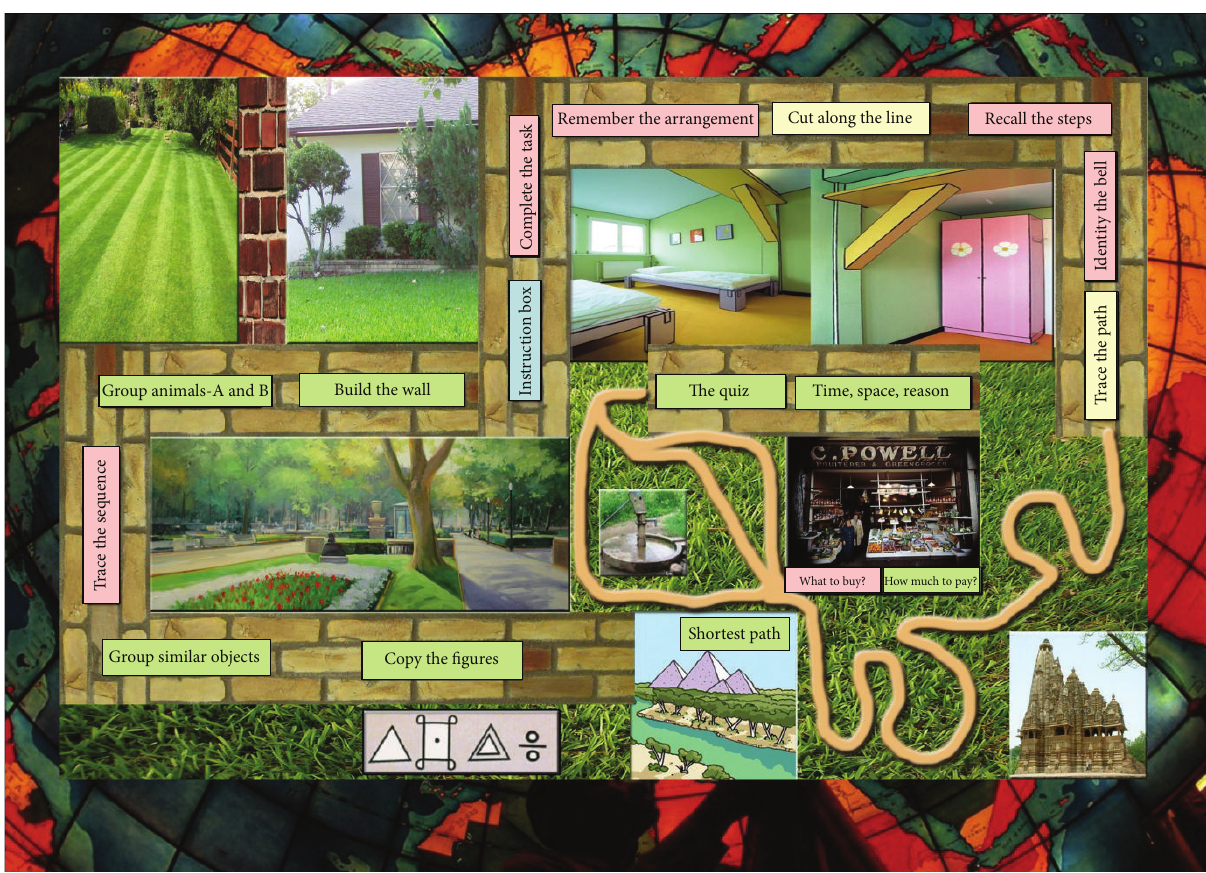
Figure 1: MALT test board. The test is administered clock-wise starting from Step 1, “Copy the figures.” The red steps test memory, green- cognition, and yellow-psychomotor skills. The scores are noted on instruction cum scoring sheet (Table 2).